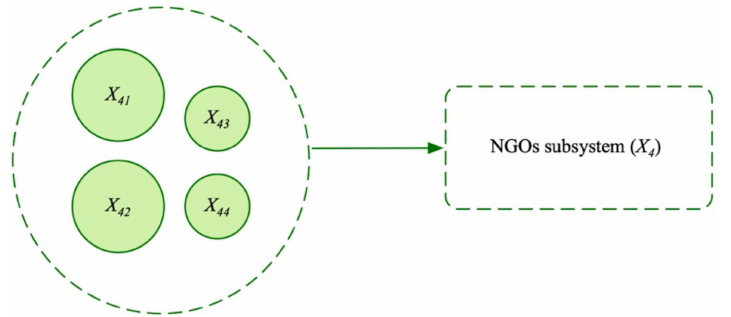
Figure 7. Indicators interaction in NGOs